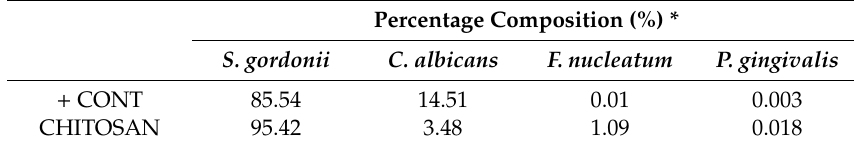
Figure 6. Compositional analysis of re-grown multi-species biofilm on bovine dentine discs. Biofilms were grown in RPMI / THB in 24-well plates for 24 h. After incubation, the biofilms were disrupted and diluted to 1:5 and then inoculated on pre-sterilized bovine dentine discs placed in a 24-well plate treated with chitosan at 0.7 mg / mL. Following additional 24 h incubation, the total CFE / mL ( A ) and composition of the regrown biofilms ( B ) were assessed using qPCR. Data were analyzed by the Mann–Whitney test. Data representative of n = 3 (**** p < 0.0001). Table 4. Percentage composition of the mixed-species biofilm model grown on dentine discs following “prevention” treatment.